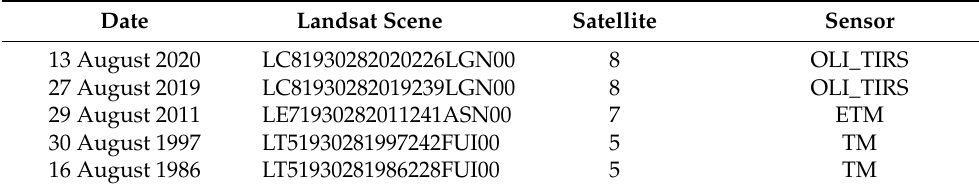
Table 1. Landsat scenes used for the reconstruction of the total vegetation